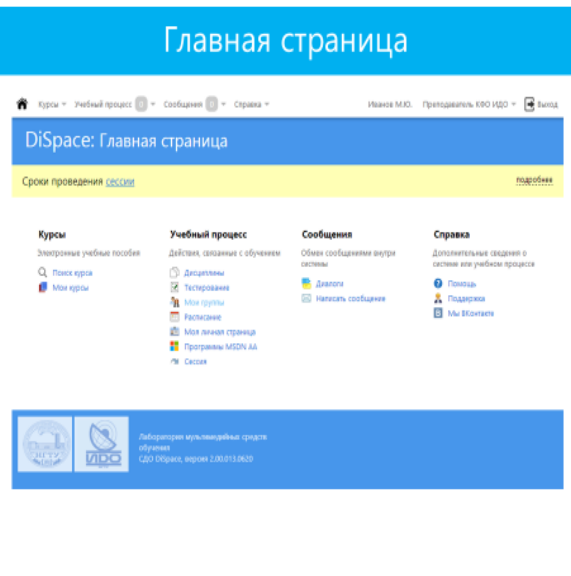
Figure 1 . LMS DiSpace 2. 0 and testing